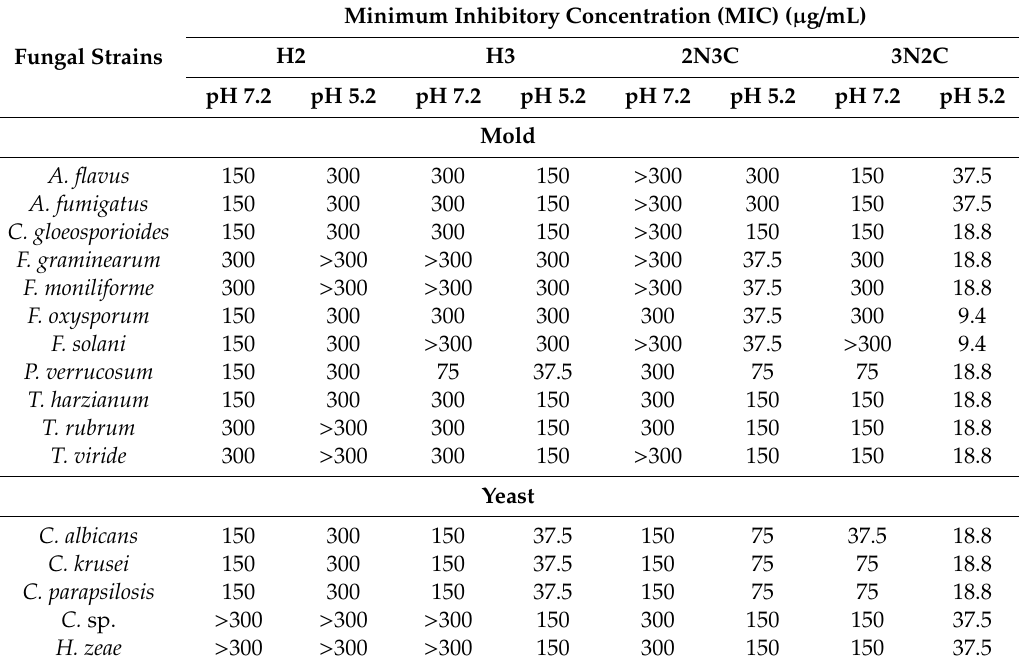
Table 1. Antifungal activity of Trx H2 / H3 / 2N3C / 3N2C proteins against mold and yeast fungal